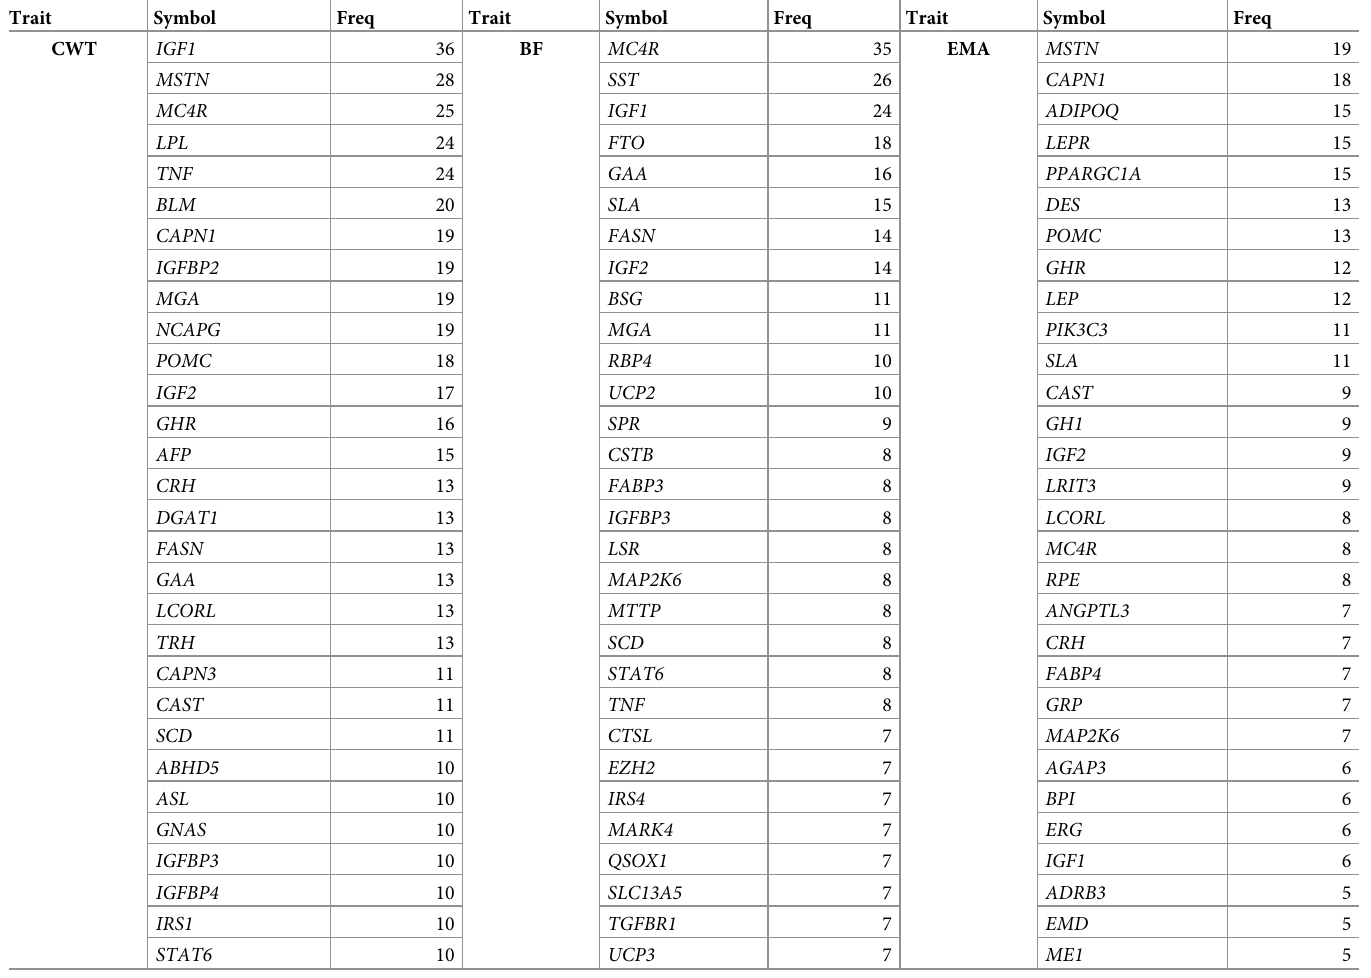
clusters were found in CWT. The most significant markers at position 10710350 in chromo- some 4 are involved in the intron region of CALCR gene (P = 10 − 29.6 ). In the genomic region PLAG1 – CHCHD7 (position: 25,015,640) intergenic regions showed the most significance nificant marker on chromosome 22 is located at a downstream gene variant of PPARG (posi- tion: 57,362,666; P = 10 − 6.5 ). The other most significant markers in chromosomes 2, 13, and 23 clusters are located in INSIG2 – EN1 (position: 70,895,063; P = 10 − 5.97 ), APCDD1L – VAPB (position: 58,449,824; P = 10 − 7.3 ), and BMP5 – HMGCLL1 (position: 4,622,146; P = 10 − 16.9 ) intergenic region. Three clusters showed significance in EMA. The most significant markers in chromosomes 3, 6, and 14 are involved in the S100A10 – THEM4 (position: 18,822,190; P = 10 − 6.2 ), LCORL – SLIT2 (position: 39,932,557; P = 10 − 12.5 ), and PLAG1 – CHCHD7 (position: 25,015,640; P = 10 − 26.6 ). For meat quality traits, only one marker at position 98,540,675 on chromosome 7 showed significance for D_SF (P = 10 − 7.4 ), located in an intron variant of the CAST gene. Table 2. The 30 genes symbol that appeared with highest frequency in text mining. Trait Symbol Freq Trait Symbol Freq Trait Symbol Freq CWT